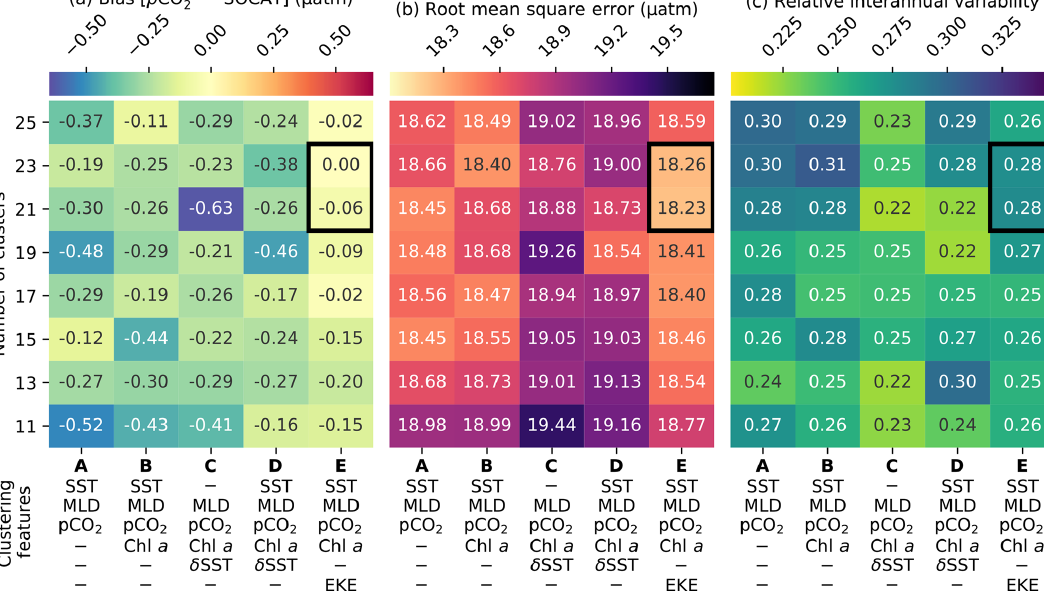
Figure 5. Heat maps showing the average cluster (a) bias, (b) RMSE and (c) relative interannual variability ( R iav ) for different cluster configurations, where smaller scores are better for all metrics. The rows show the number of clusters, and the columns show clustering feature- variable configurations. Each cluster contains the average of the scores for four regression methods: support vector regression, extremely randomised trees, gradient-boosting machine and feed-forward neural network. The black box indicates clustering configurations that perform well across all metrics; note that a value of R iav < 0 . 3 falls within the best category of performance in Rödenbeck et al. (2015).